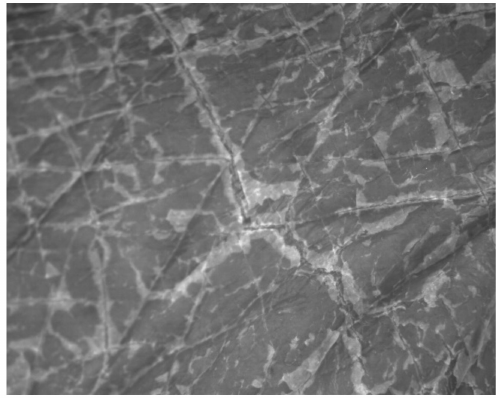
Figure 2. Visioscan ® VC 98 image of dehydrated skin; area: right hand, outer side.